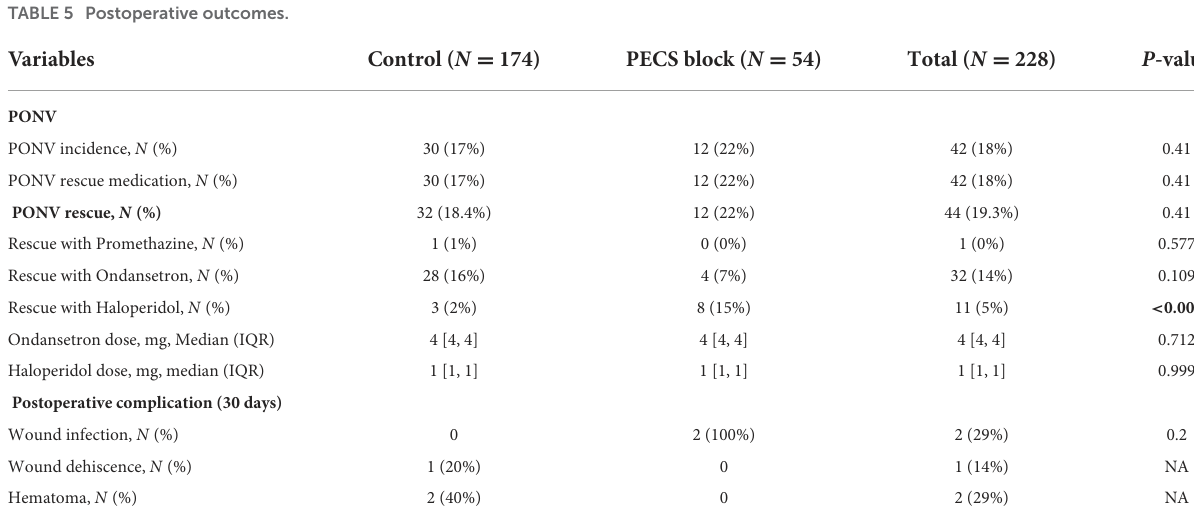
TABLE 5 Postoperative